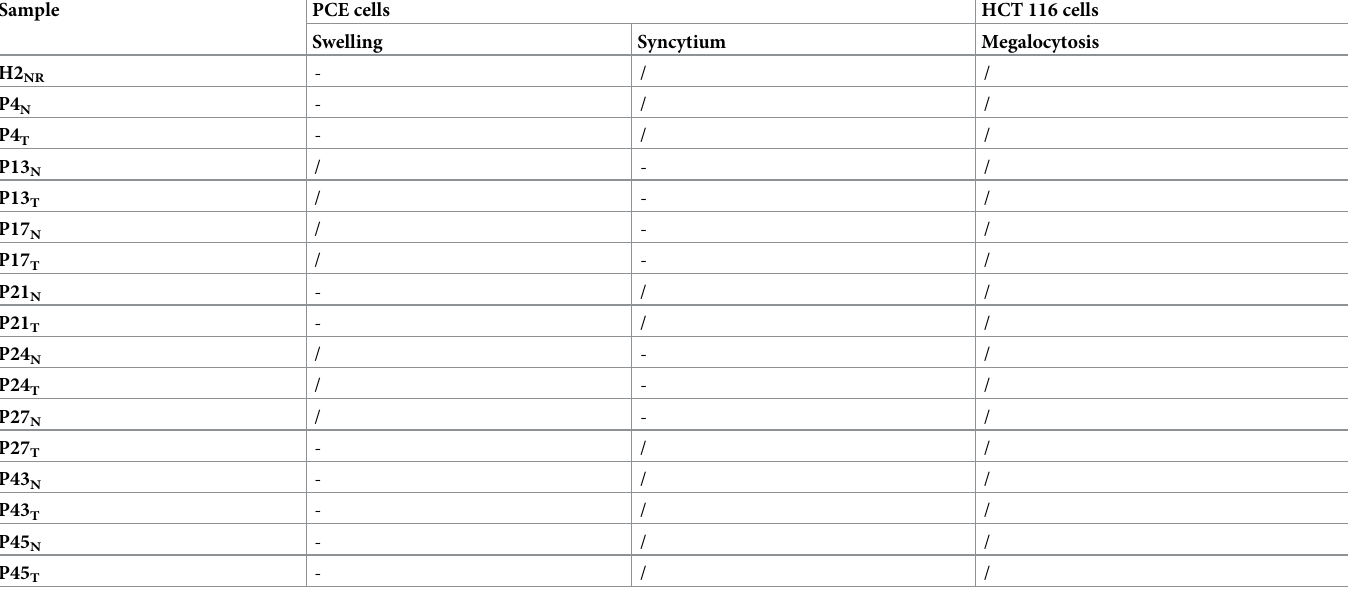
Table 2. Different cytopathic effect of PCE and HCT116 cell lines infected with pks + E . coli . Sample PCE cells HCT 116 cells Swelling Syncytium